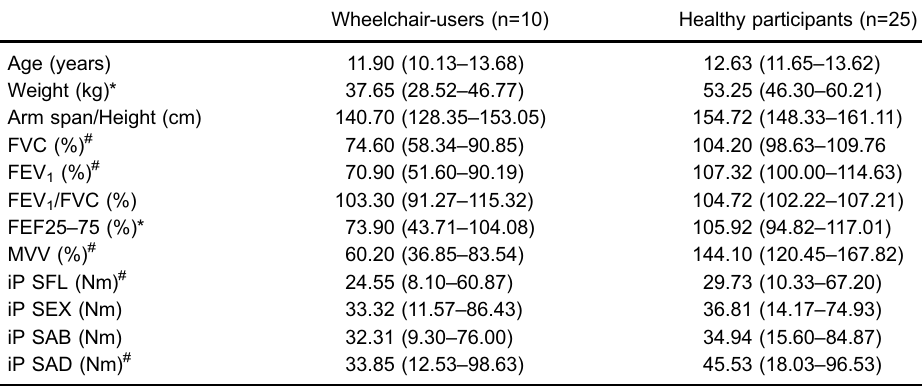
Table 2. Anthropometric, spirometric, and dynamometric variables for the participants. Wheelchair-users